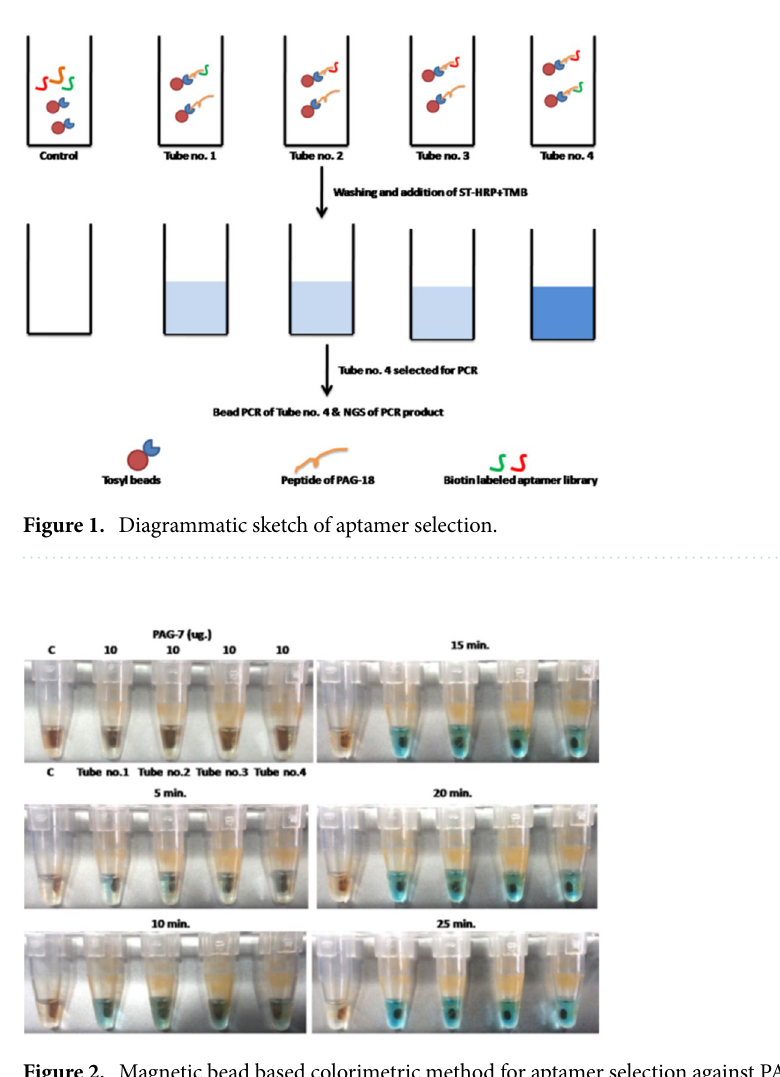
Figure 2. Magnetic bead based colorimetric method for aptamer selection against PAG-7